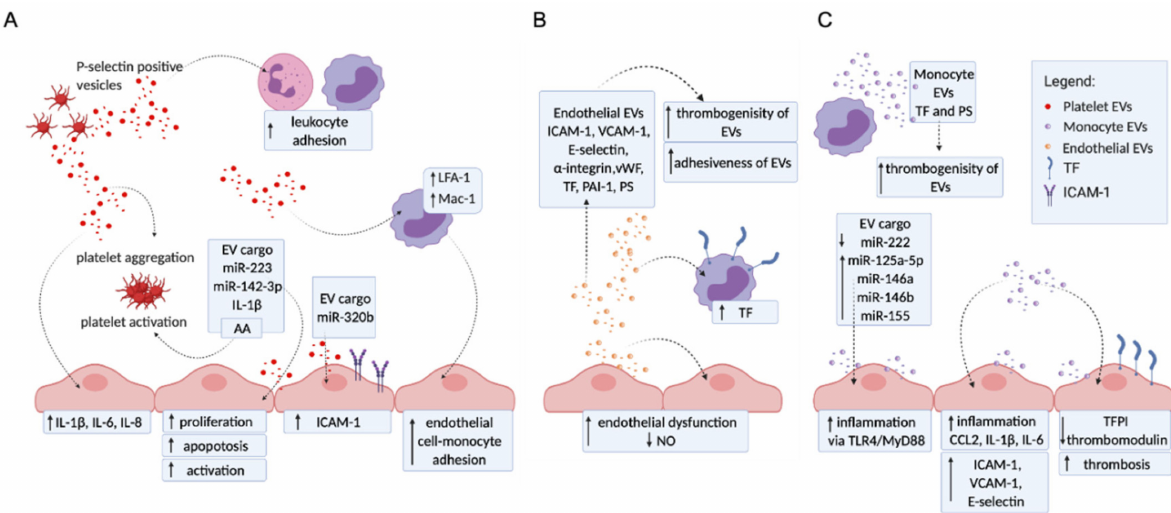
Figure 1. Activation of platelets, monocytes, and endothelial cells by EVs derived from different cells. Schematic repre- sentation of the potential in vitro mechanisms focusing on vascular function, inflammation, and thrombosis. ( A ) Platelet EVs (red spots) can stimulate endothelial cells and monocytes via direct interaction or by cargo delivery (miR and lipids). Furthermore, platelet EVs can also act via a feedback loop causing platelet aggregation and activation. Platelet EVs induce endothelial cell activation, proliferation, and apoptosis by the transfer or miR-223 and miR-142-3p, while ICAM-1 expression is induced by the delivery of miR-320b. Increased adhesion between endothelial cells and monocytes, as well as between leukocytes, is mediated by platelet EVs. ( B ) Endothelial EVs (orange spots) were found to have a procoagulant profile expressing vWF, TF, PAI-1, and PS as well as increased adhesive properties expressing VCAM-1, ICAM-1, E-selectin, and α -integrin. Endothelial EVs promote the procoagulant profile of monocytes by induction of TF expression on these cells and endothelial dysfunction by attenuating the production of nitric oxide from endothelial cells ( C ). Monocytes release procoagulant EVs (purple spots) that carry TF and PS. Furthermore, monocyte EVs interact with endothelial cells, causing increased expression of adhesion molecules (ICAM-1, VCAM-1, and E-selectin), increased inflammation, and procoagulant profile by reducing the expression of anticoagulant molecules (TFPI and thrombomodulin). Monocyte EVs transfer miR (miR125a-5p, miR-222, miR-146a, miR-146b, and miR-155) and induce inflammation in endothelial cells. CCL2: C-C motif chemokine ligand 2; ICAM-1: intercellular adhesion molecule 1; IL: interleukin; LFA1: lymphocyte